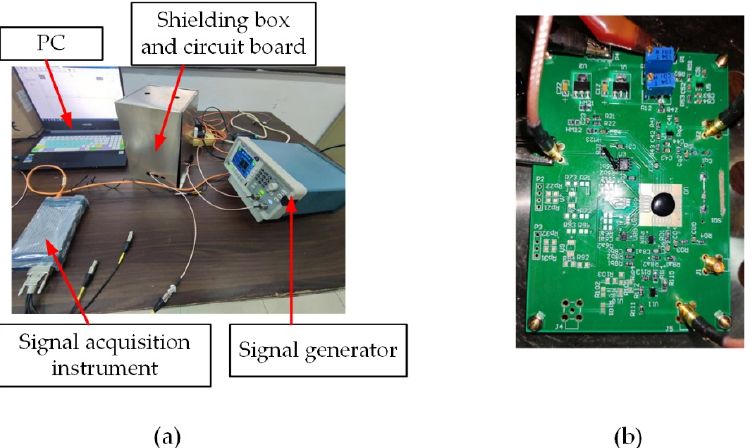
Figure 3. Experiment platform system and analog amplifier circuit board. ( a ) The test system and ( b ) the analog amplifier circuit.